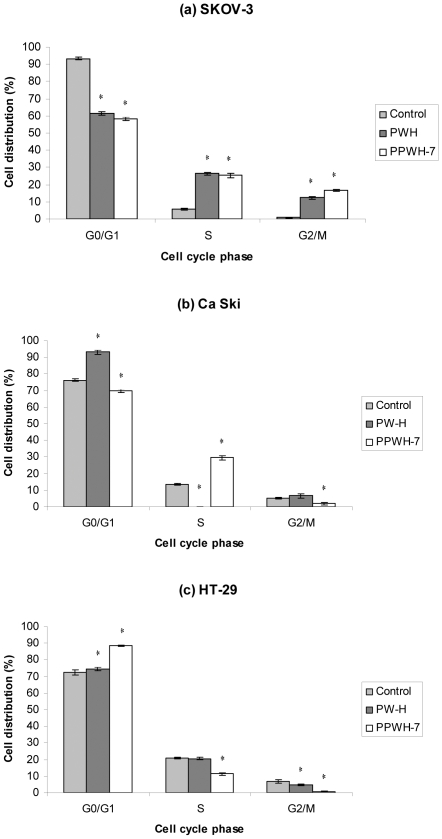
Effects of P. watsonii on the cell cycle of (a) SKOV-3, (b) Ca Ski and (c) HT-29 cells.Cells (1×106 cells/mL) were incubated in the absence (control) or presence of PW-H and PPWH-7 for 24 hours and then analyzed by flow cytometry. Data are representative of one of the three similar experiments. Significant differences were compared between control and treated cells (*p<0.05).